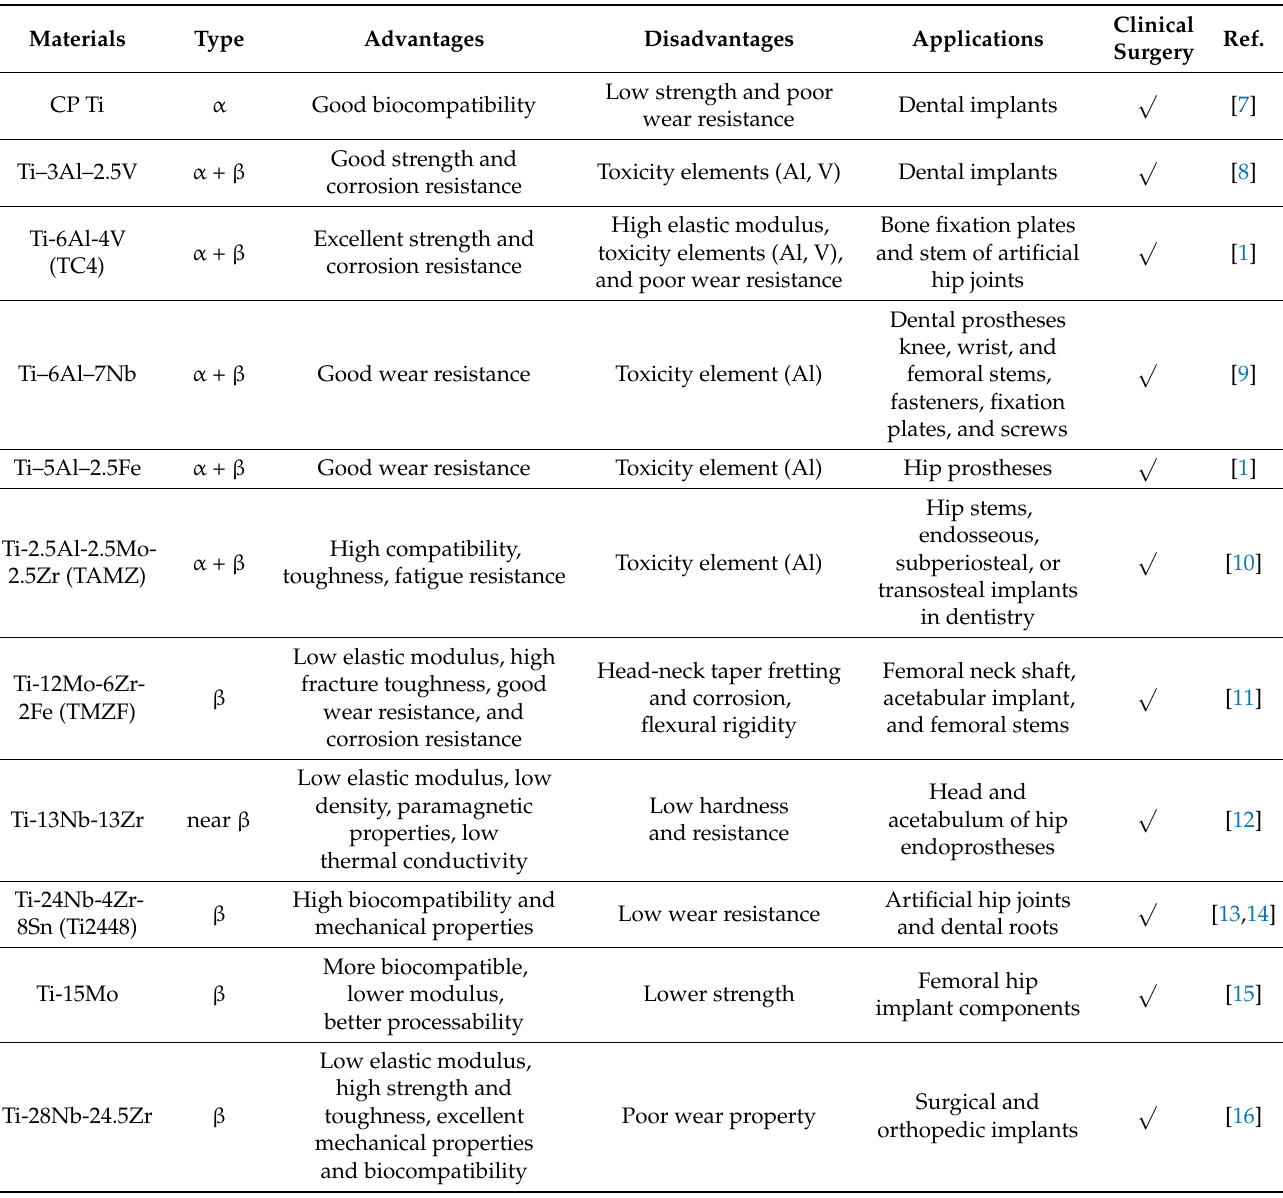
Table 1. The uses, advantages, and disadvantages of Ti and its